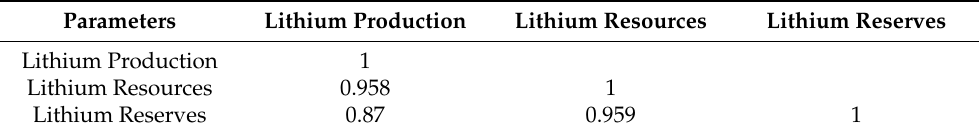
Table 5. Pearson correlation of mines effect group at a significant level of 0.01.